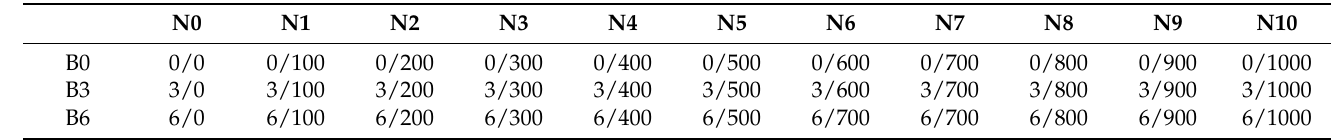
Table 3. Indexation of N and B